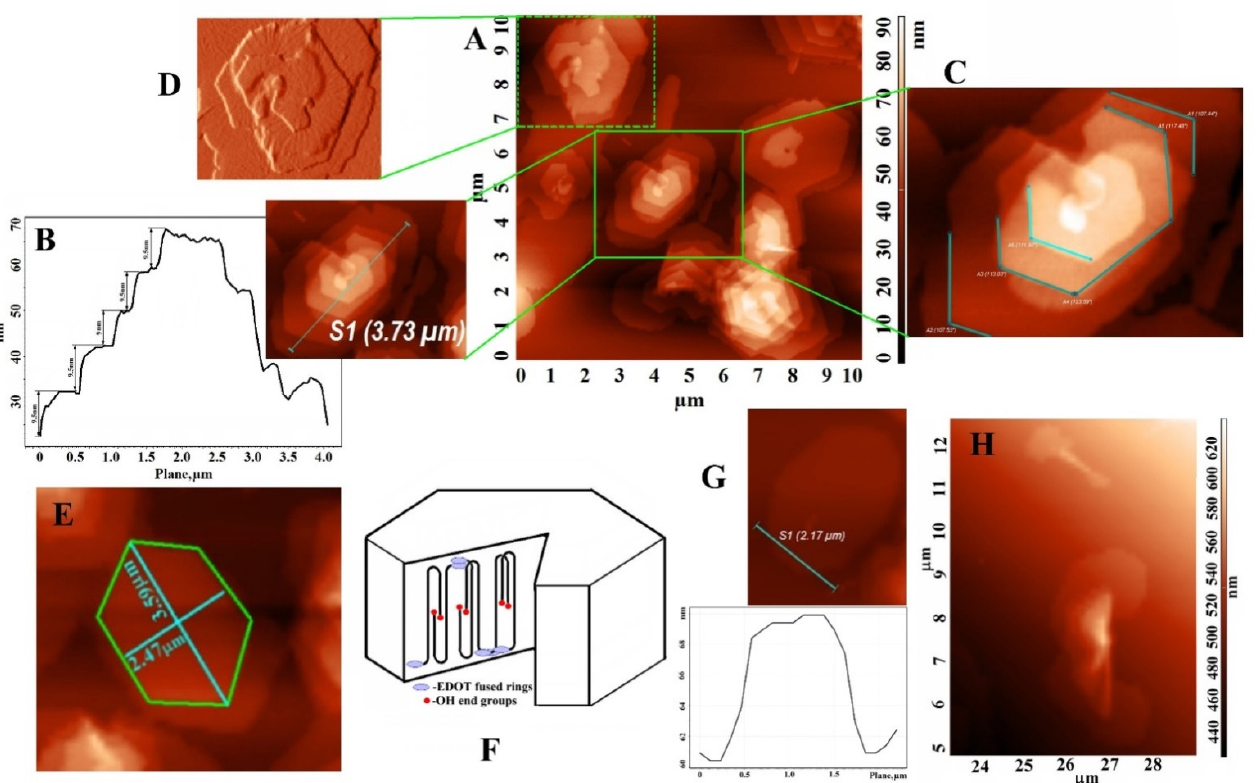
Figure 5. ( A ) AFM height image of EDOT-PCL platelets as almost perfect hexagonally shaped single crystals (SCs); ( B ) AFM height image of a multi-lamellar SC and its cross-sectional analysis, which shows individual lamellae thicknesses; ( C ) angle values between two consecutive {110} faces and between the {110} and {100} faces of SCs; ( D ) AFM amplitude image showing the usual PCL SC lamellae’s striations; ( E ) the aspect ratio of the perfect six-sided facetted EDOT-PCL SC; ( F ) schematic representation of possible OCL chain-folding, thereby forming the hexagonal lamella of EDOT-PCL SC; ( G ) AFM height image and cross-sectional analysis of a non-perfect mono-lamellar SC; ( H ) AFM height image showing straight and helical rods breakout crystallization and the starting of 2D platelet formation.